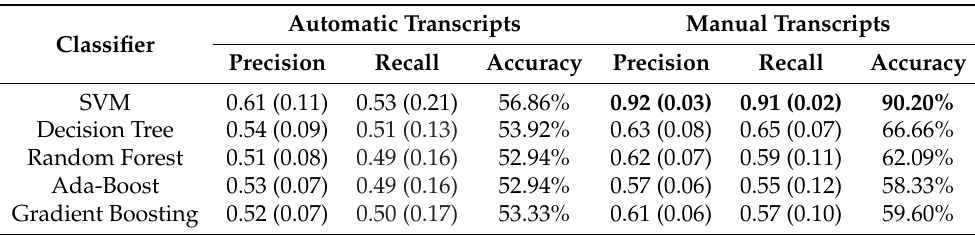
Table 5. The level of competence classification results using several classifiers for manual and automatic transcriptions (the standard deviation of the precision and recall).